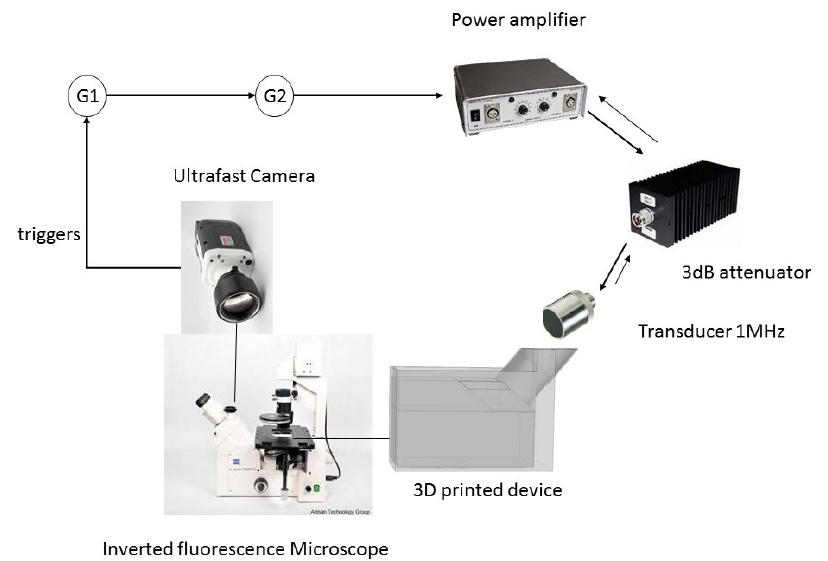
Figure 1. Two generators, one master, G1 (Agilent Technologies, Santa Clara, CA, USA), and one slave, G2 (Rigol Technologies, Beijing, China), were used to trigger and generate a 1MHz sinusoidal signal with chosen pulse repetition frequency, duty cycle, and amplitude. A power amplifier AAP0.5-6-200 (ADECE, Veigné, France) set to its maximum gain amplified the signal. A 100W, 3dB power attenuator was added to the output of the amplifier to protect it from reflections, due to potential impedance mismatch with the ultrasonic transducer. The 1 MHz immersion transducer ICFM016 (Sofranel, Sartrouville, France) powered by the generators and amplifier emitted the ultrasounds: Sinusoidal signal with chosen pulse repetition frequency, duty cycle, and amplitude. The GUVs sonoporation mix was a 10 µL solution composed of 1/3 DLPC GUVs so- lution with 2% DOPE Rhodamine, 1/3 MB solution (10:1 MB to cell ratio), 1/3 of a 240 mM sucrose buffer with 2 mM Lucifer Yellow.